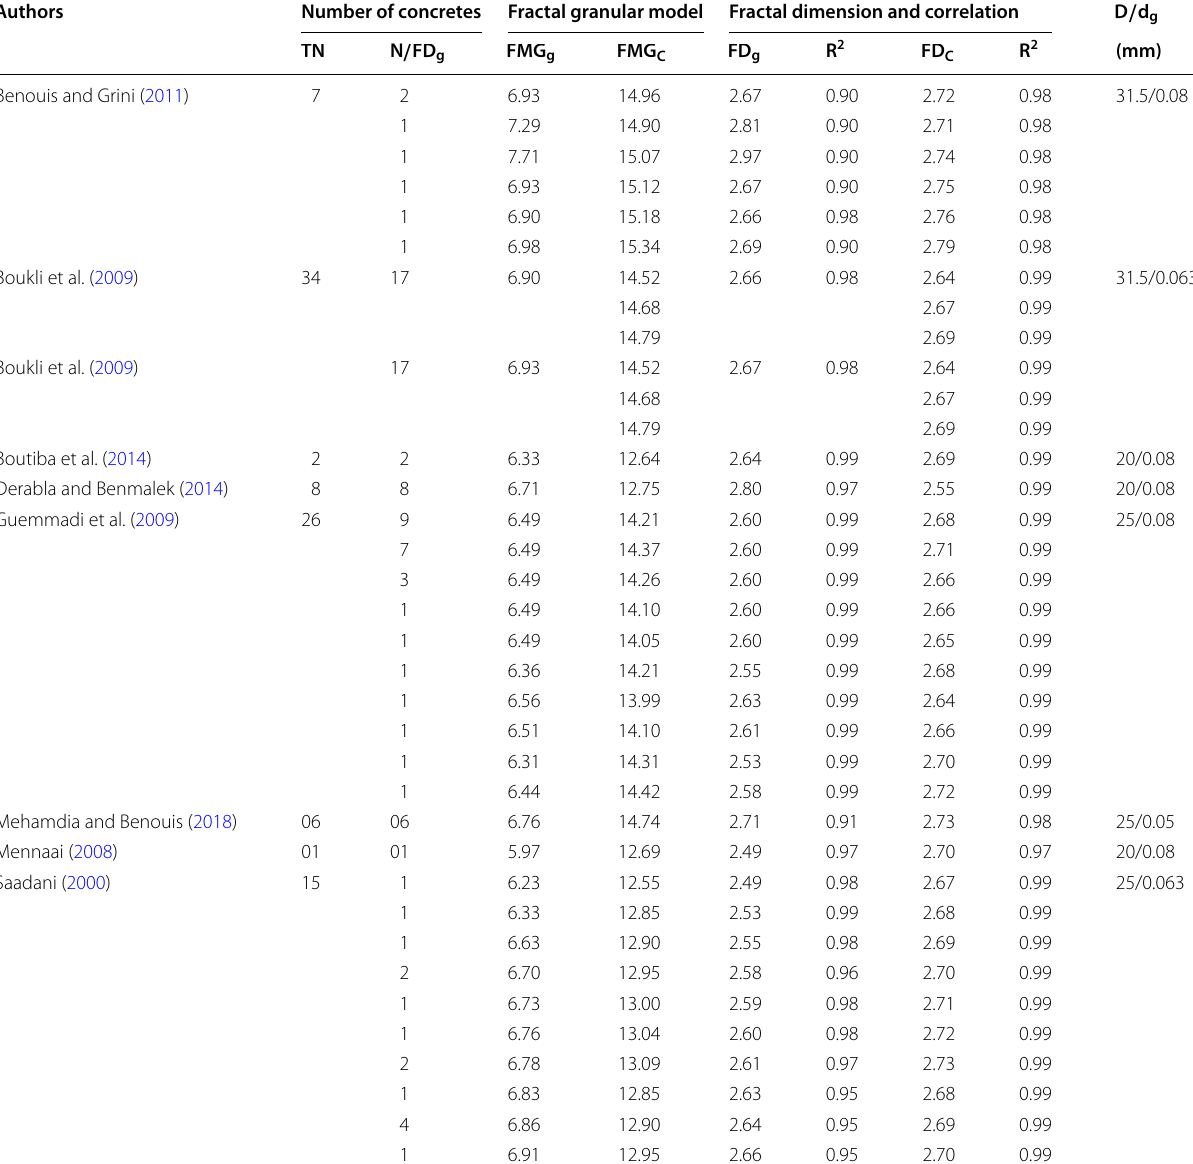
Table 5 Concrete with the same FGM g value of the base granular